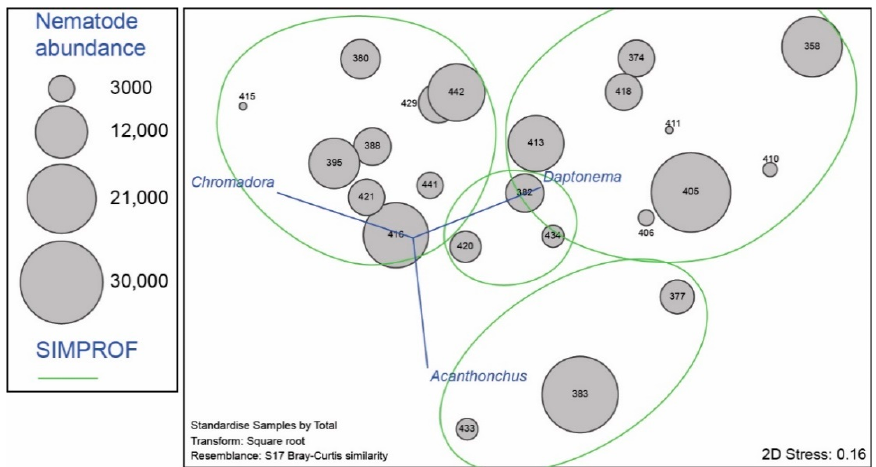
Figure 6. nMDS based on nematode genera on loggerhead carapaces. Each carapace is represented by a bubble representative of total nematode abundance on each carapace. Superimposed vectors represent Pearson correlations between the taxa (correlation coefficient > 0.7) and the nMDS axes, comprising Chromadora , Daptonema and Acanthonchus . Green lines separate four main groups based on significant cluster SIMPROF analysis ( p < 0.05).